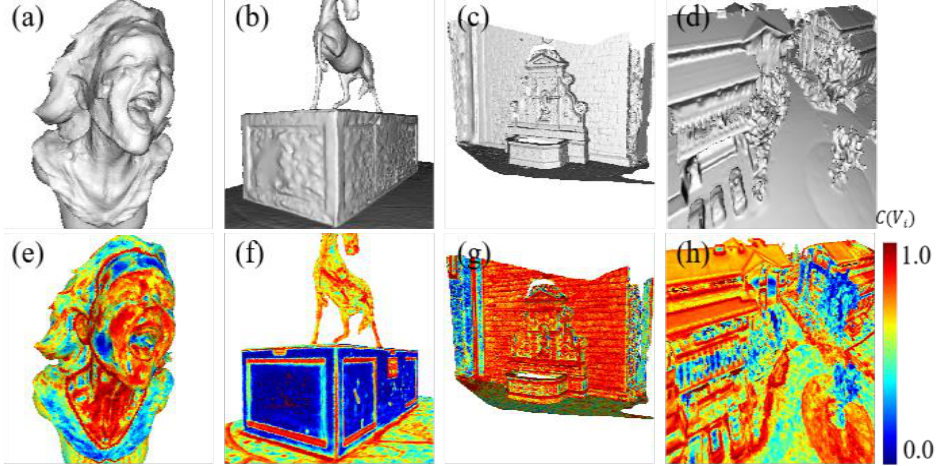
Figure 6. ZNCC maps of different meshes. ( a – d ) are the initial meshes, and ( e – h ) are the correspond- ing ZNCC maps. It is worth noting that general mesh denoising methods only remove noise based on geometric information. In contrast, this paper adaptively applies a denoising gradient based on the photo-consistency metric, which is conducive to removing significant errors in the initial mesh (see Figure 1). Finally, our TDR combines the photometric gradient and regularization gradient by 𝛽 : 𝑔 𝑇𝐷𝑅 (𝑉) = 𝑔 𝑝ℎ𝑜𝑡𝑜𝑇𝐷𝑅 (𝑉) + 𝛽𝑔 𝑟𝑒𝑔𝑢𝑙𝑎𝑟𝑖𝑧𝑎𝑡𝑖𝑜𝑛 (𝑉) (12) 𝑔 is an abbreviation for gradient. 𝑔 𝑝ℎ𝑜𝑡𝑜𝑇𝐷𝑅 (𝑉) is the photometric gradient of our TDR method in each iteration. 𝑔 𝑝ℎ𝑜𝑡𝑜𝑇𝐷𝑅 (𝑉) replaces the 𝜕𝑀(𝑥 𝑖 ) as 𝜕𝑀 𝑇𝐷𝑃𝐺 (𝑥 𝑖 ) in (Equation (3)). 2.4. Initialization and Implementation Details